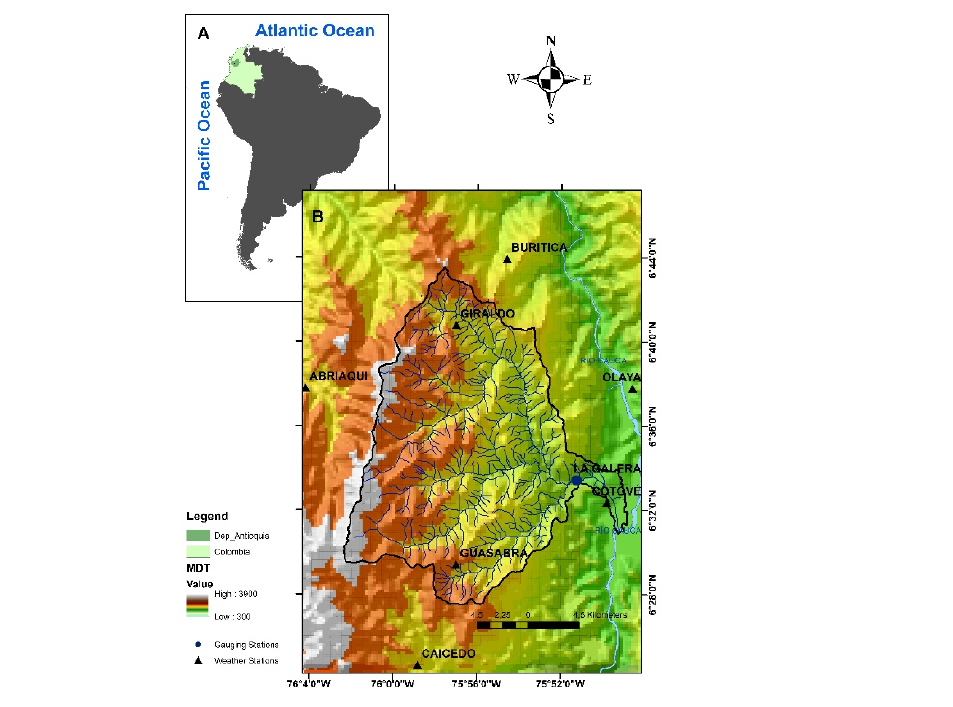
Figure 1. ( A ) Location of the Tonusco River Basin within South America and Colombia. ( B ) Tonusco river catchment with its main tributaries and location of weather and gauging stations.